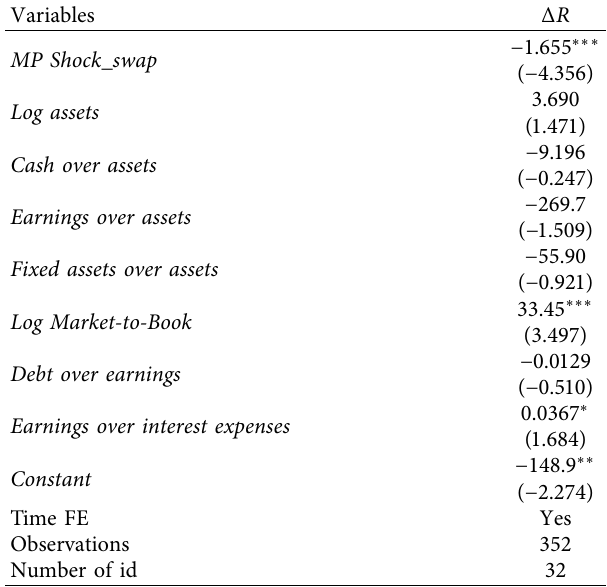
Table 6: Unexpected IEOMP and stock price of listed enterprises.